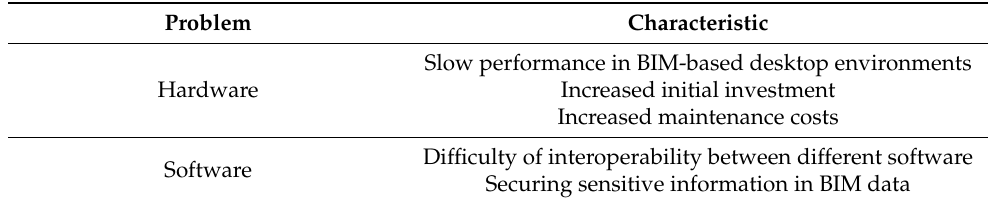
Table 3. Hindrance factors of BIM